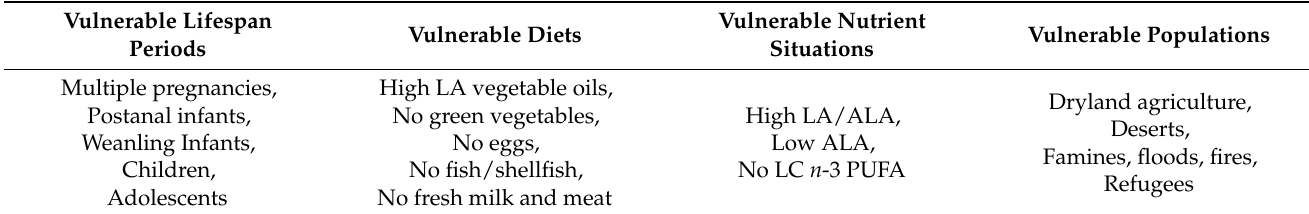
Table 7. Conditions and situations where the brain DHA levels are vulnerable to